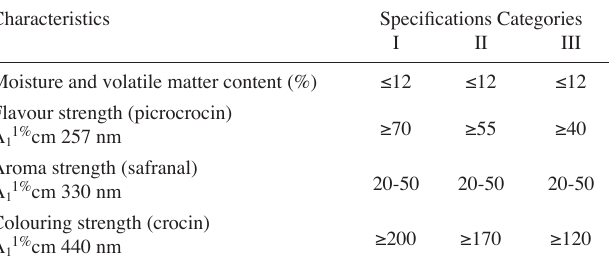
Tab. 1: Quality category limits for saffron in filaments according to ISO 3632 1,2:2010-2011. Characteristics